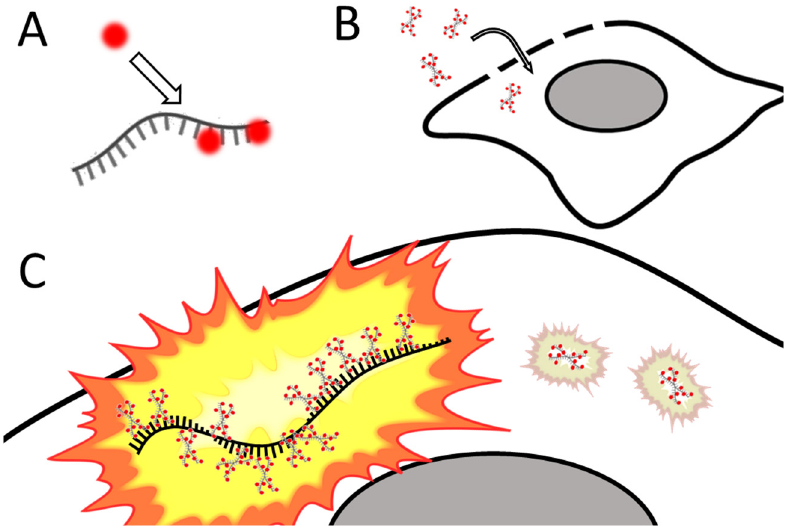
Figure 4. Simplified schematic of MTRIPs. ( A ) Fluorophores are bound to synthetic oligomers (ligands). ( B ) Tagged ligands are introduced into the live cell via temporary permeabilization. ( C ) Ligands bind to target mRNA (not o scale); multiply bound mRNAs are distinguished from unbound probes by intensity. After [123] .